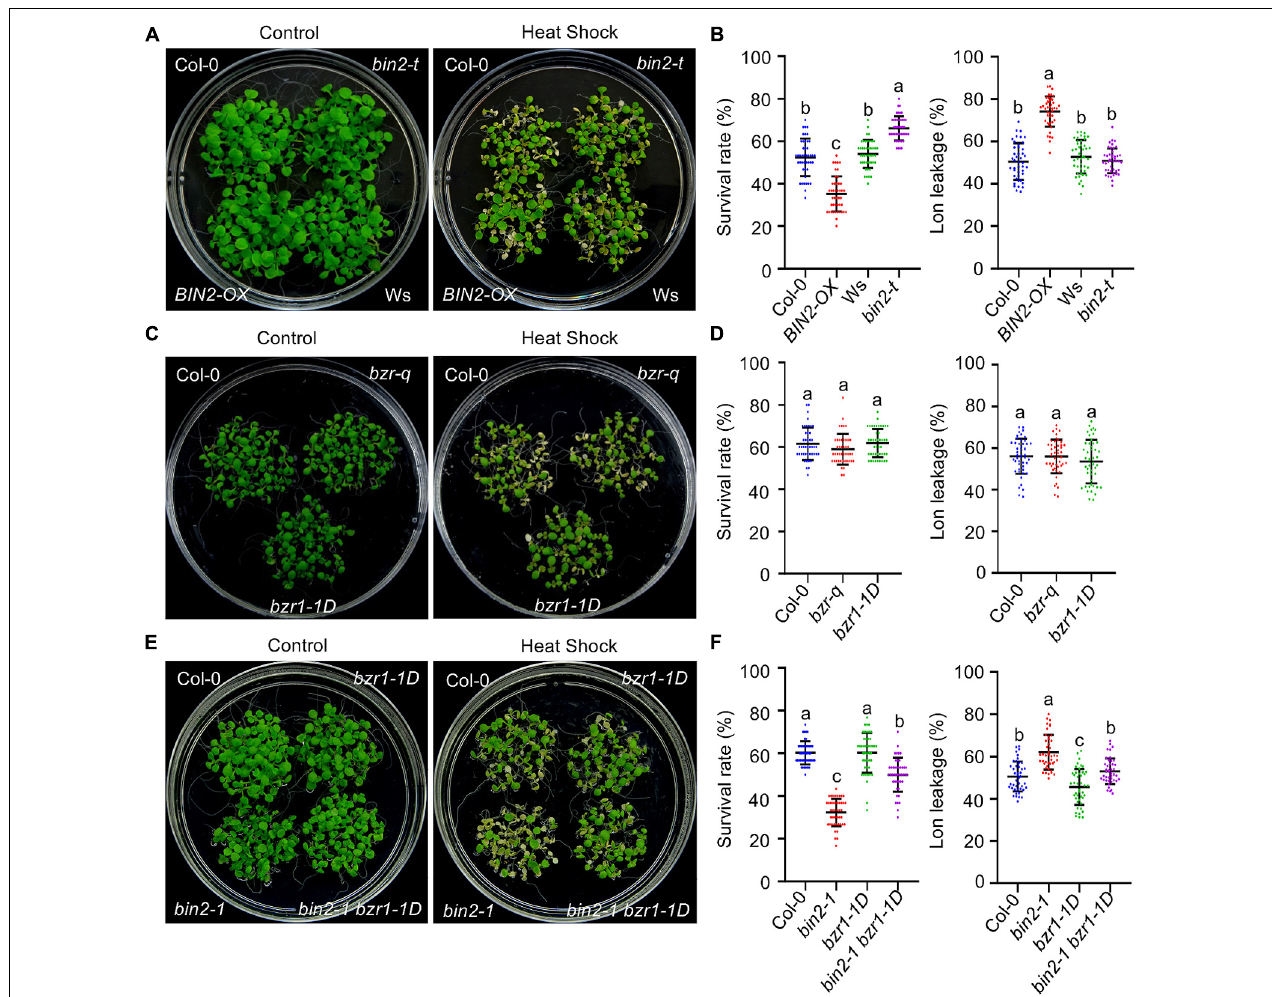
FIGURE 3 | The BR signaling component BIN2 (but not BZRs) plays a major role in regulating acquired thermotolerance in Arabidopsis . (A,C,E) Photographs of HS-treated and untreated plants after 3 days of recovery at 22 ◦ C. bin2-t represents the bin2-3 bil1 bil2 triple mutant and bzr-q is a bes1 beh1 beh2 beh3 quadruple mutant. (B,D,F) Quantification of the survival rates of and ion leakage from the plants shown in panels (A,C,E) . Error bars indicate the mean ± SD. Different lowercase letters indicate statistically significant differences ( p < 0.05, one-way